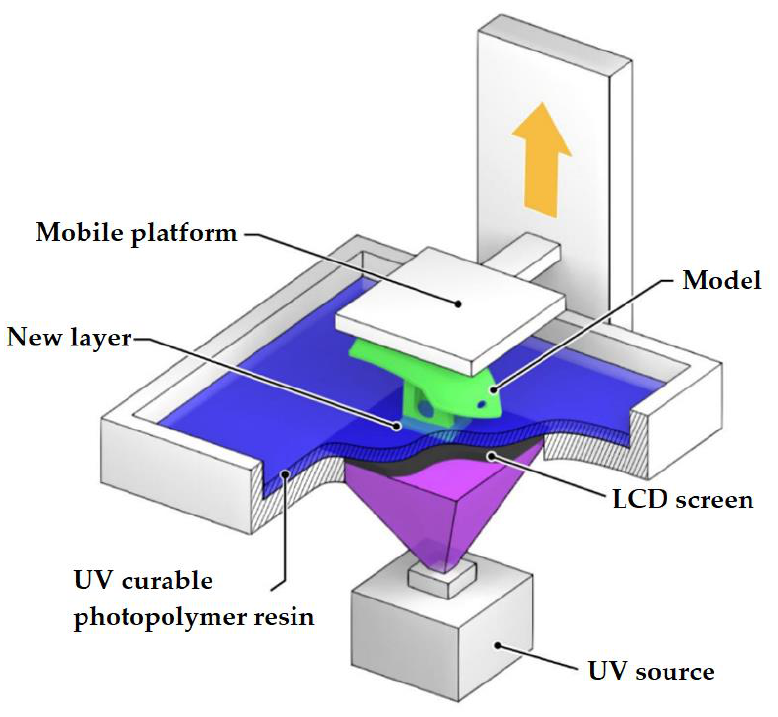
Figure 5. DLP method.